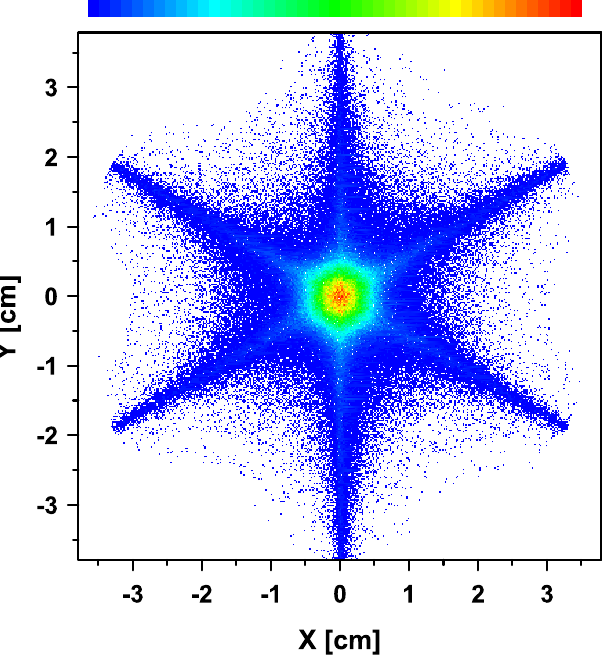
FIG. 3. (Color) The x - y profile of the ion density. The maximum density at the axis of the source is 3 : 2 (cid:1) 10 11 cm (cid:2) 3 . profiles of the electron density and of the mean ion charge state are shown along the x axis (between the star arms). The values are averaged along the z axis. The electron density reaches a maximum value of 1 : 1 (cid:1) 10 12 cm (cid:2) 3 on the axis, and the plasma diameter is around 1 cm. The mean charge state increases from 1 þ at the plasma periphery to 4 þ at the source axis.